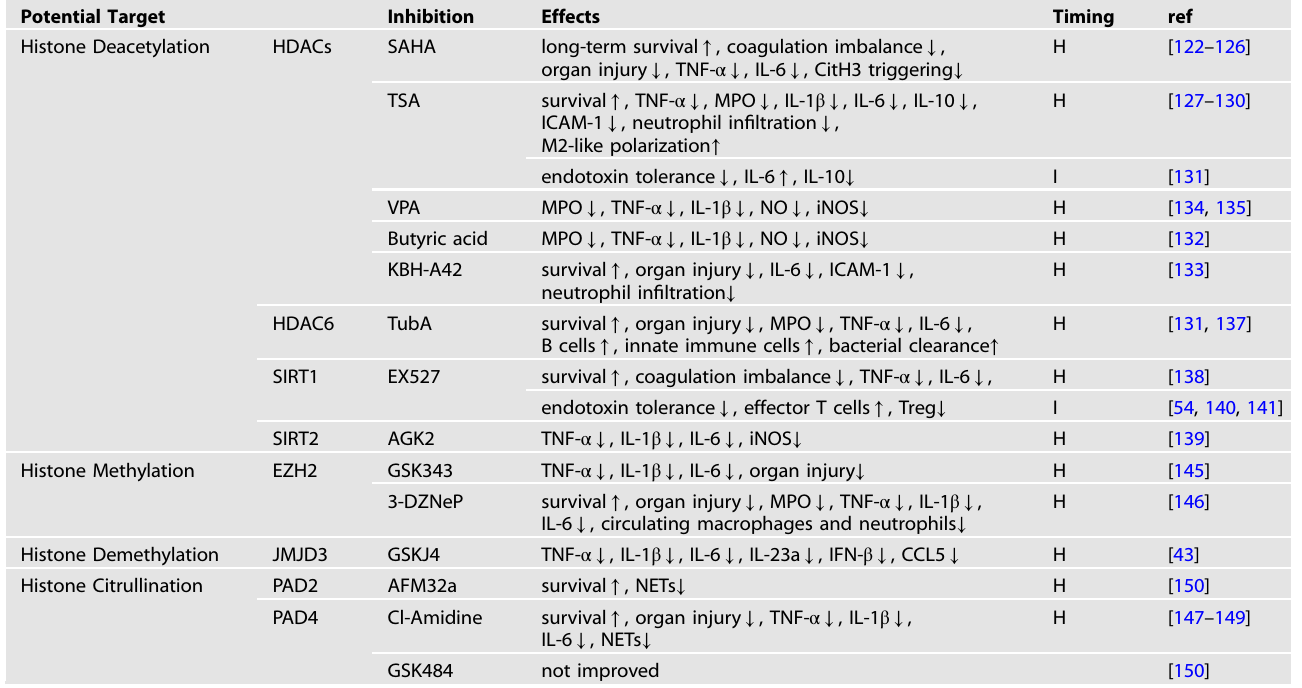
Table 1. Potential treatments targeting histone modi fi cations in